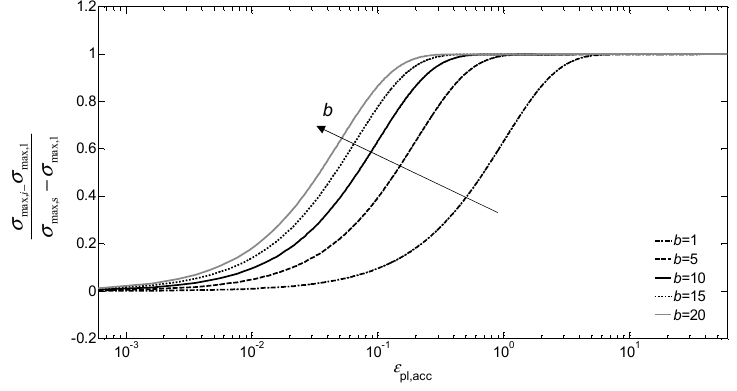
ff erent values of b